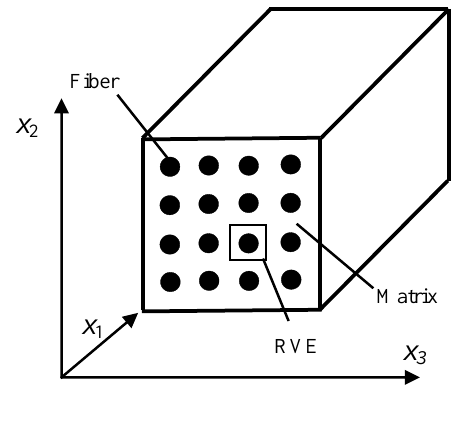
Figure 2. Discretization of the RVE.